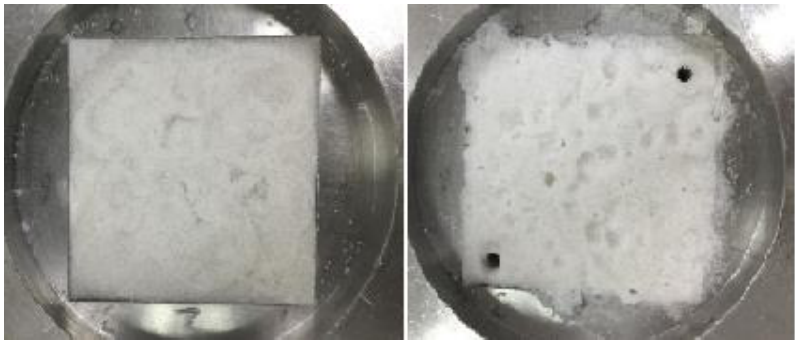
Figure 9. Sediment morphology before and after hydrate dissociation for run 1.